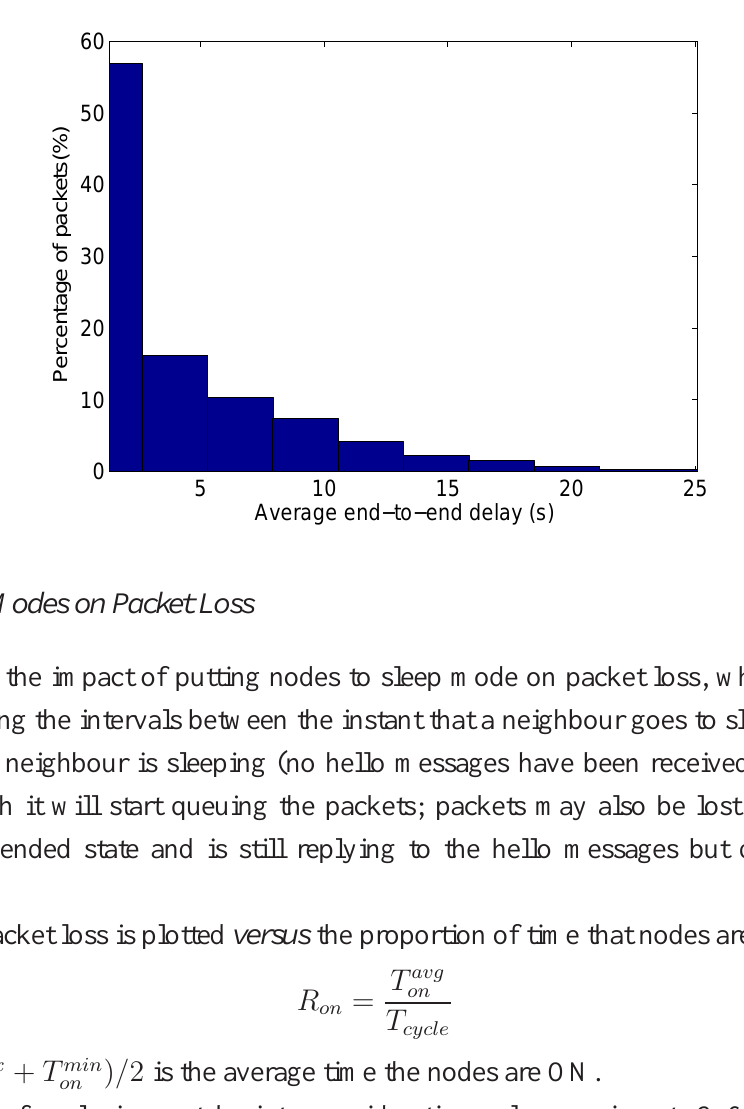
Figure 4. Histogram of delay measurements of experiment